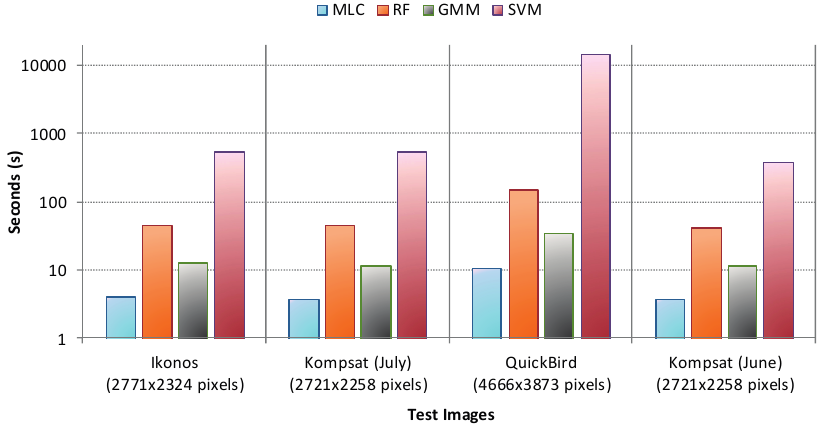
Figure 3. Processing time of each